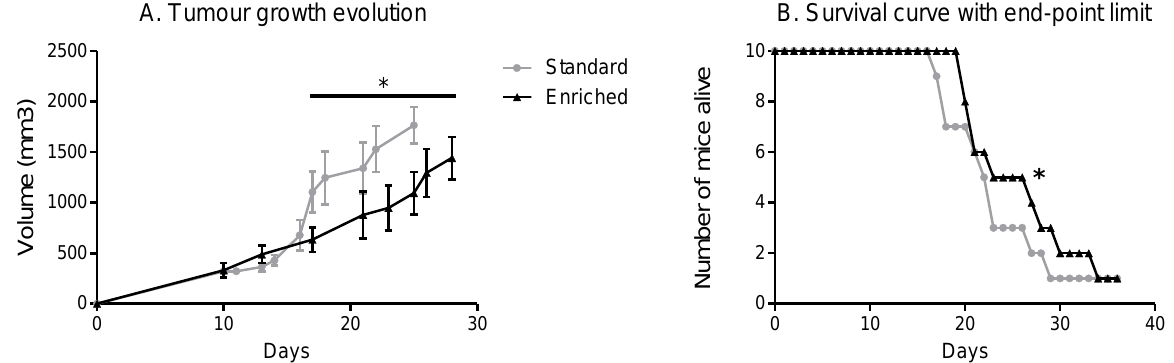
Figure 4. Spontaneous physical activity slows down tumour growth and increases survival. ( A ) Tumour growth evolution depending on the environment, results are in volume (mm 3 ) with an individual calliper measure. ( B ). Time course of survival with end-point limit. The end-point limit is a 2 cm 3 tumour, as required by the rules of ethics. Mean ± SEM ( n = 10 mice/group), Data were analysed by ANOVA repeated measures or by Mantel–Cox as appropriate. Representative data are shown: * p < 0.05, SE vs. EE.